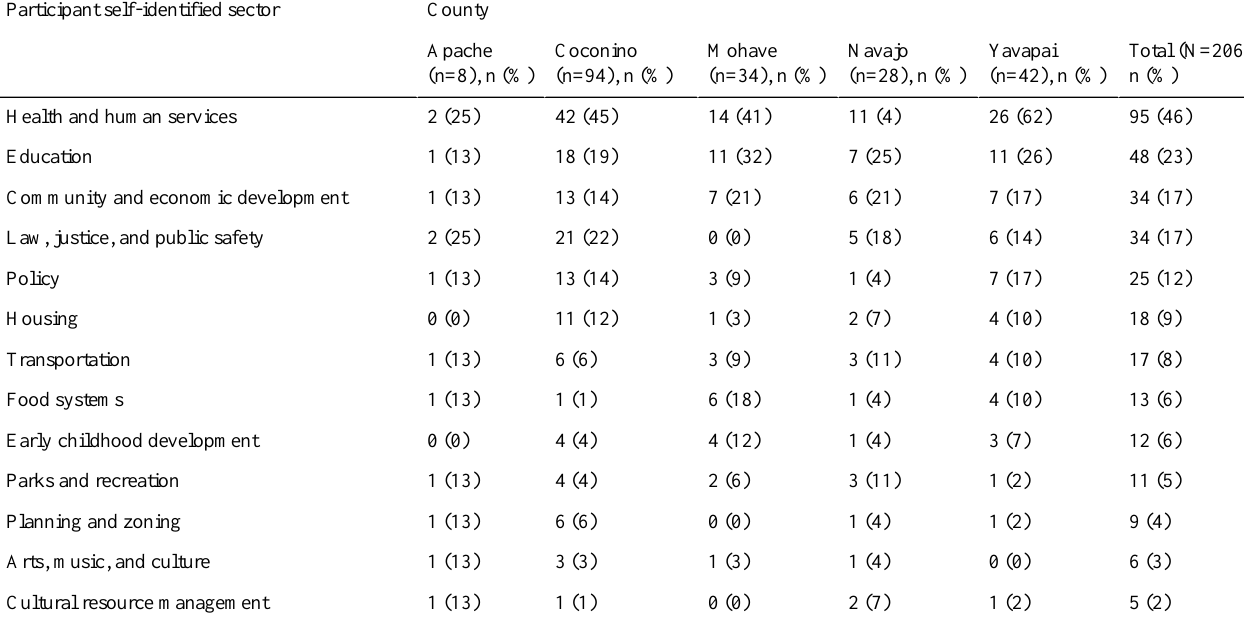
Table 2. Distribution of participants by county and self-identified